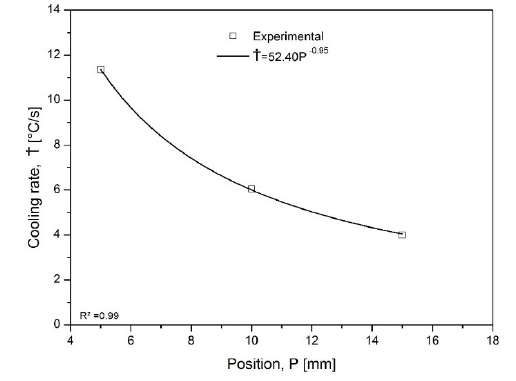
Figure 6. Cooling rate (  T ) versus position ( P ).